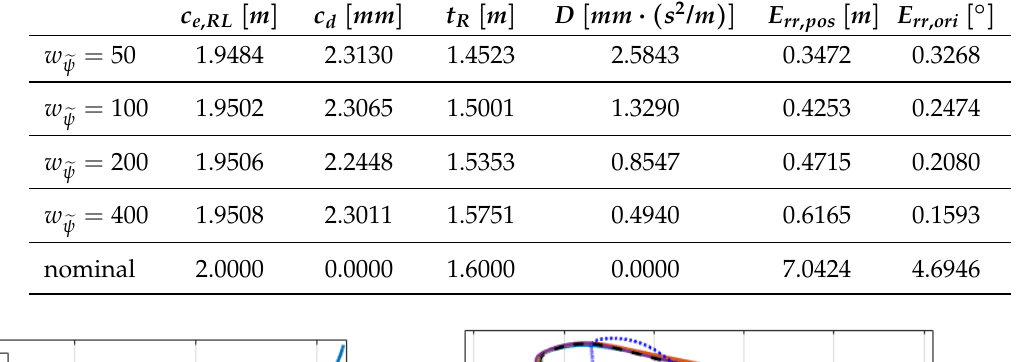
settings. (cid:101) ψ